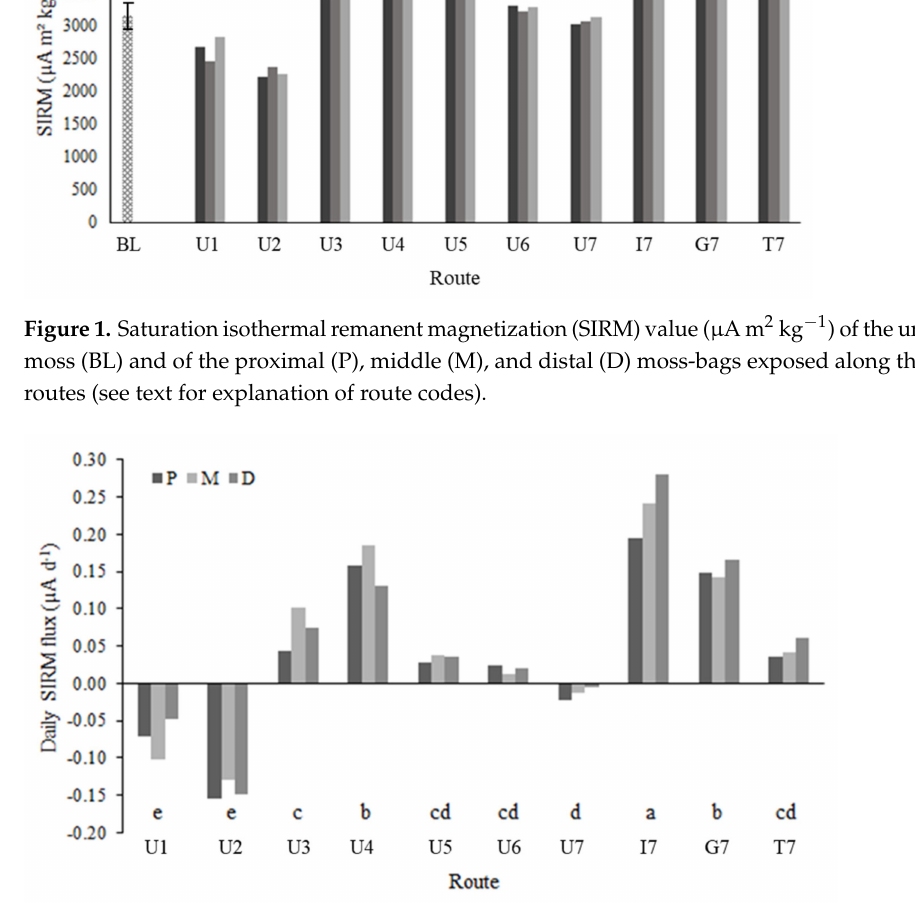
Figure 2. Daily SIRM flux ( µ A d − 1 ) of the exposed moss in the proximal (P), middle (M), and distal (D) bags, calculated as the SIRM of the exposed moss minus the SIRM value of the unexposed moss and normalized by the exposure time and specific leaf area (SLA), for each route (see text for explanation of route codes). Different letters indicate significant ( p < 0.05) differences between routes. Table 1. Correlation coefficient (R), t -value and p -value of the relationship between SIRM and elements of the exposed